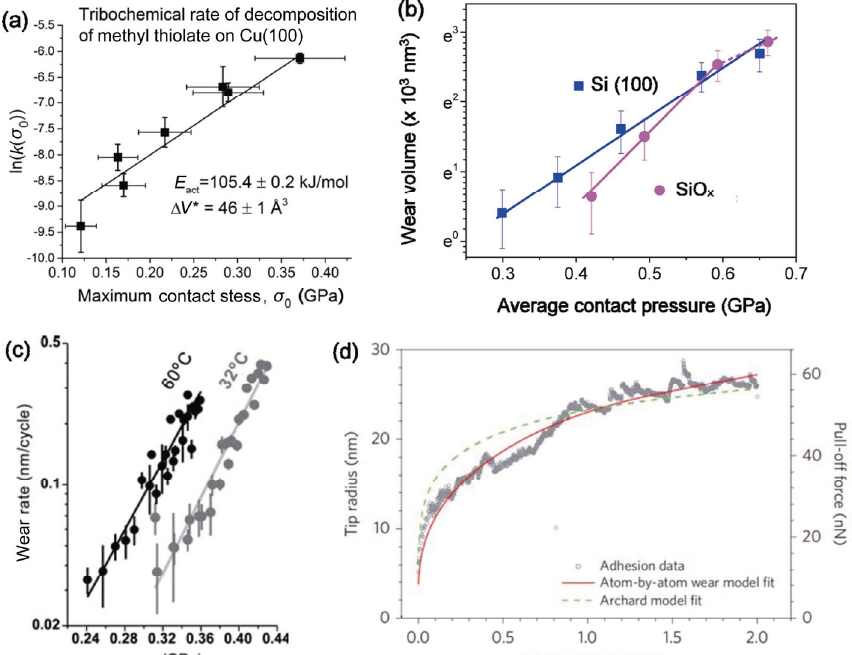
Fig. 12 Experimental results from various tribochemical wear studies. (a) Wear rate (volume) of methyl thiolate on Cu (100) at 298 K. Reproduced with permission from Ref. [119], © Royal Society of Chemistry 2020. (b) Single crystal silicon and native silicon oxide. Reproduced with permission from Ref. [120], © Springer 2017. (c) NaCl. Reproduced with permission from Ref. [121], © Elsevier B.V. 2005. All exponential increases with stress can be explained using stress-induced tribochemical wear model. (d) Evolution of tip radius as a function of sliding distance can be well fitted by decreasing surface stresses as tip becomes blunter. Reproduced with permission from Ref. [122], © American Physical Society